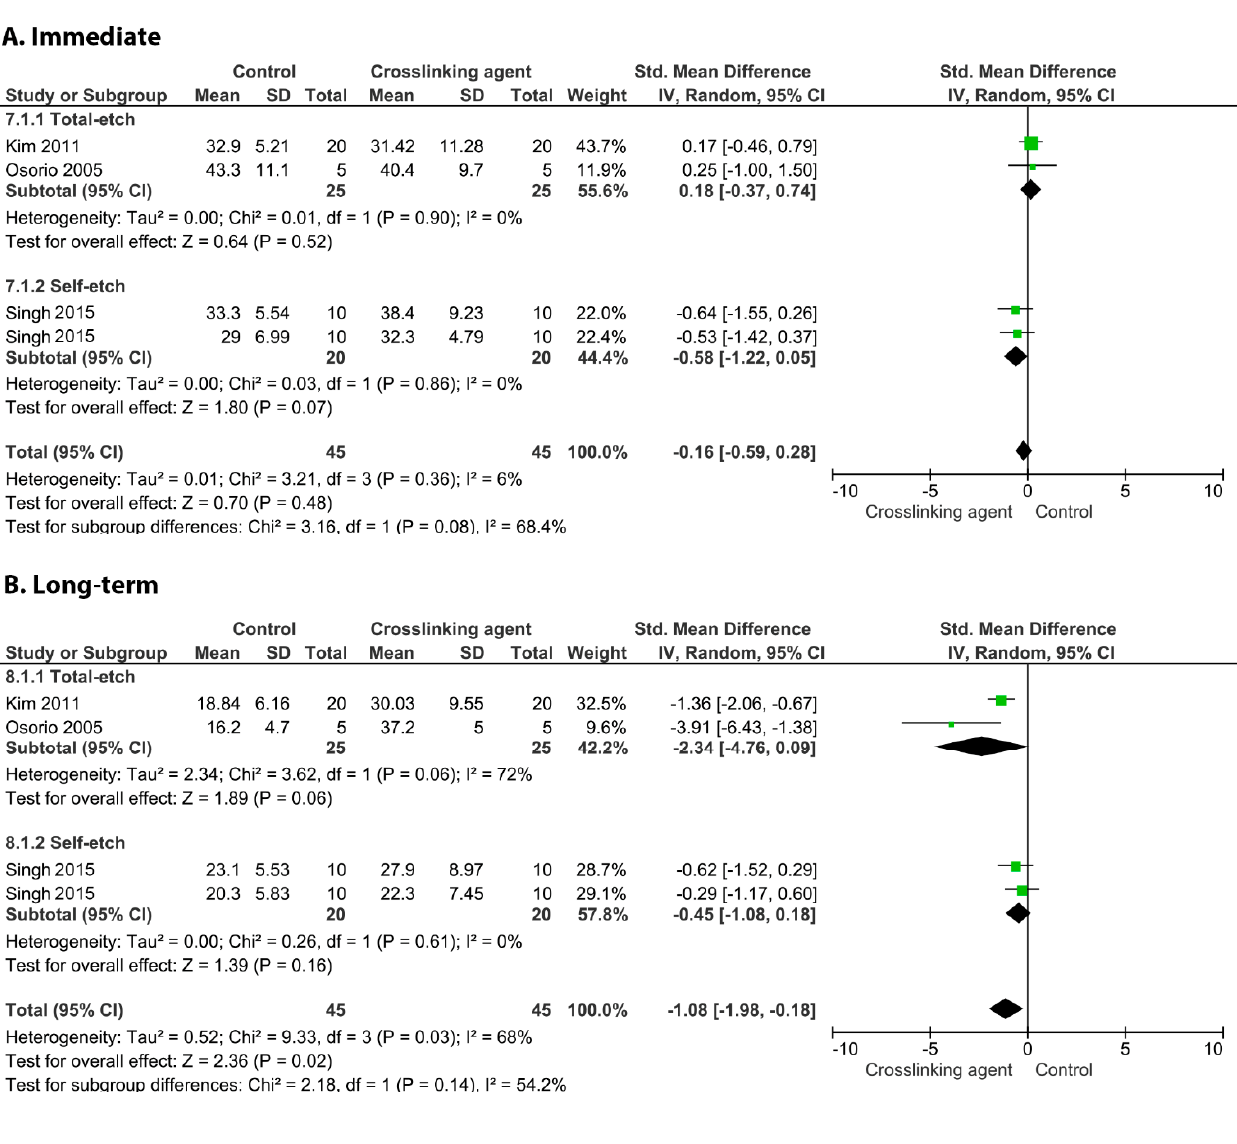
Figure 5. Forest plot of the immediate ( A ) and long-term ( B ) bond strength comparison between the EDTA crosslinking agent and the control according to the adhesive used, [85,94,111].